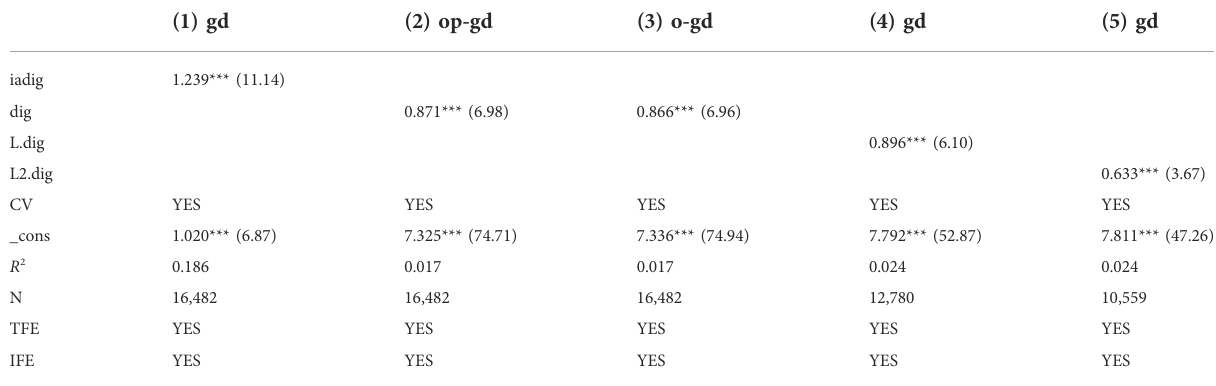
TABLE 3 Robustness test